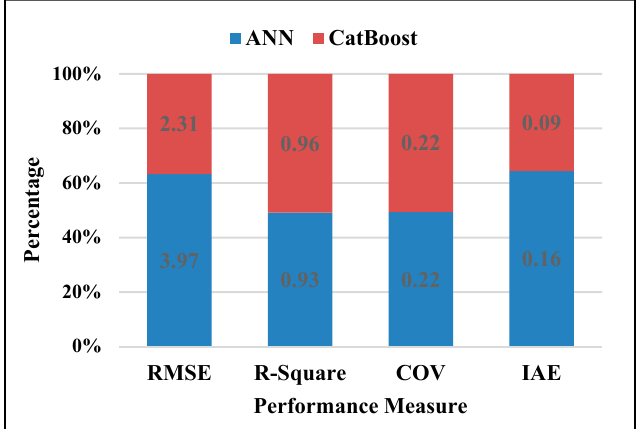
Figure 8. Performance comparison of CatBoost and ANN.